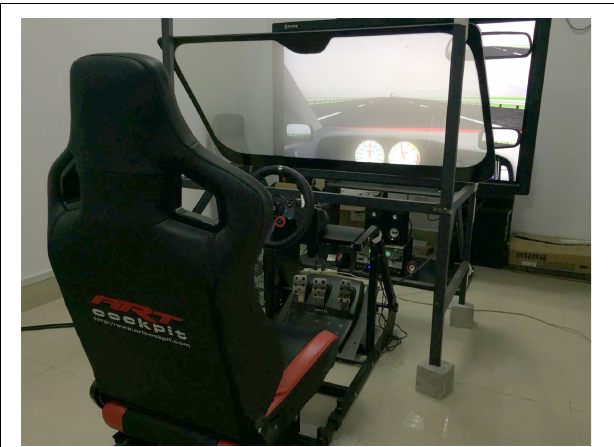
FIGURE 1 | Driving simulation in the study.